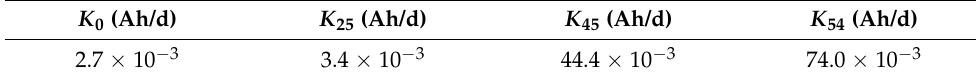
Table 3. The reaction rate of lithium metal at different